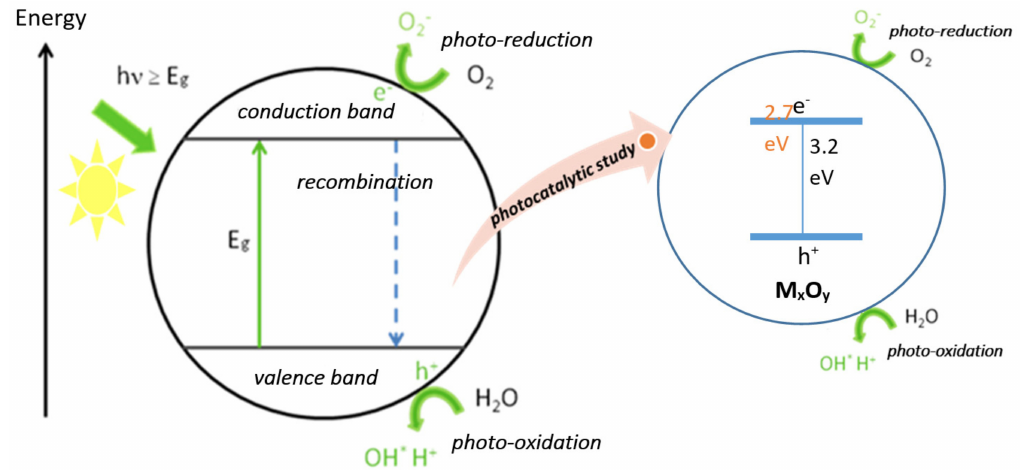
Figure 19. Photocatalytic activity of nanostructure metal